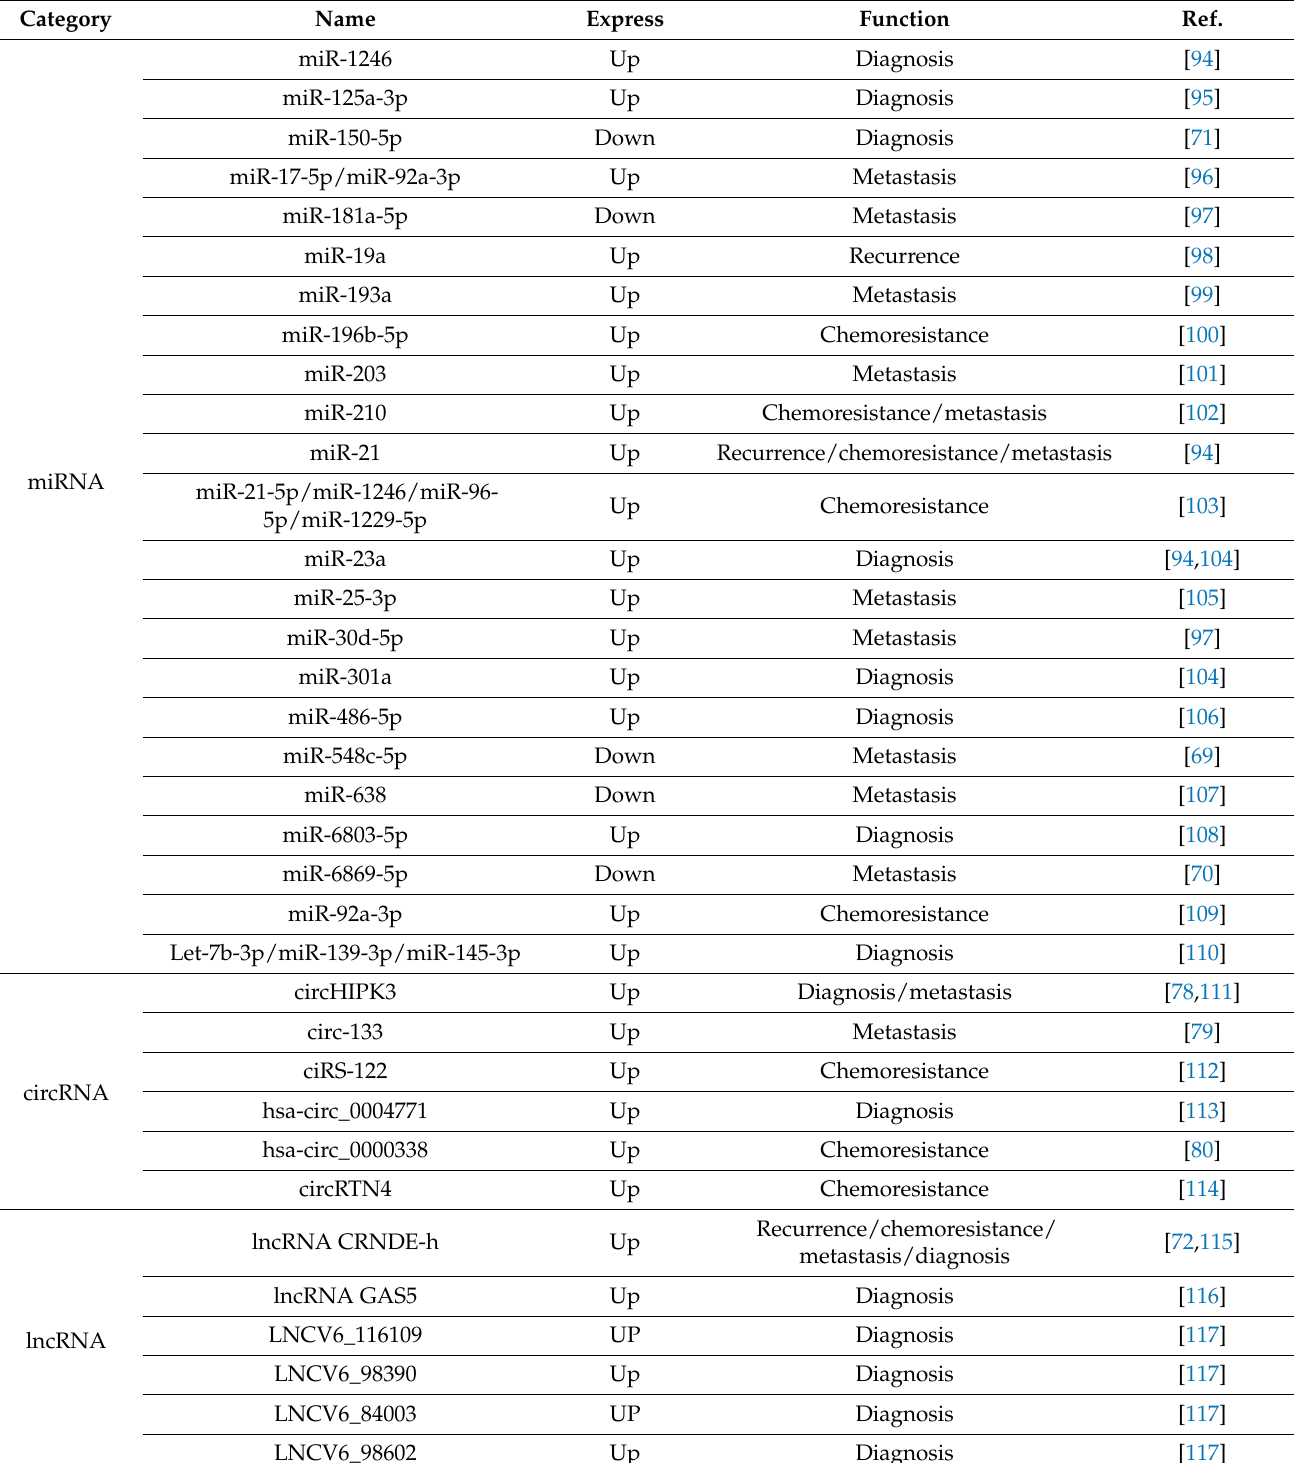
Table 2. Vesicle-related substances carried by colorectal